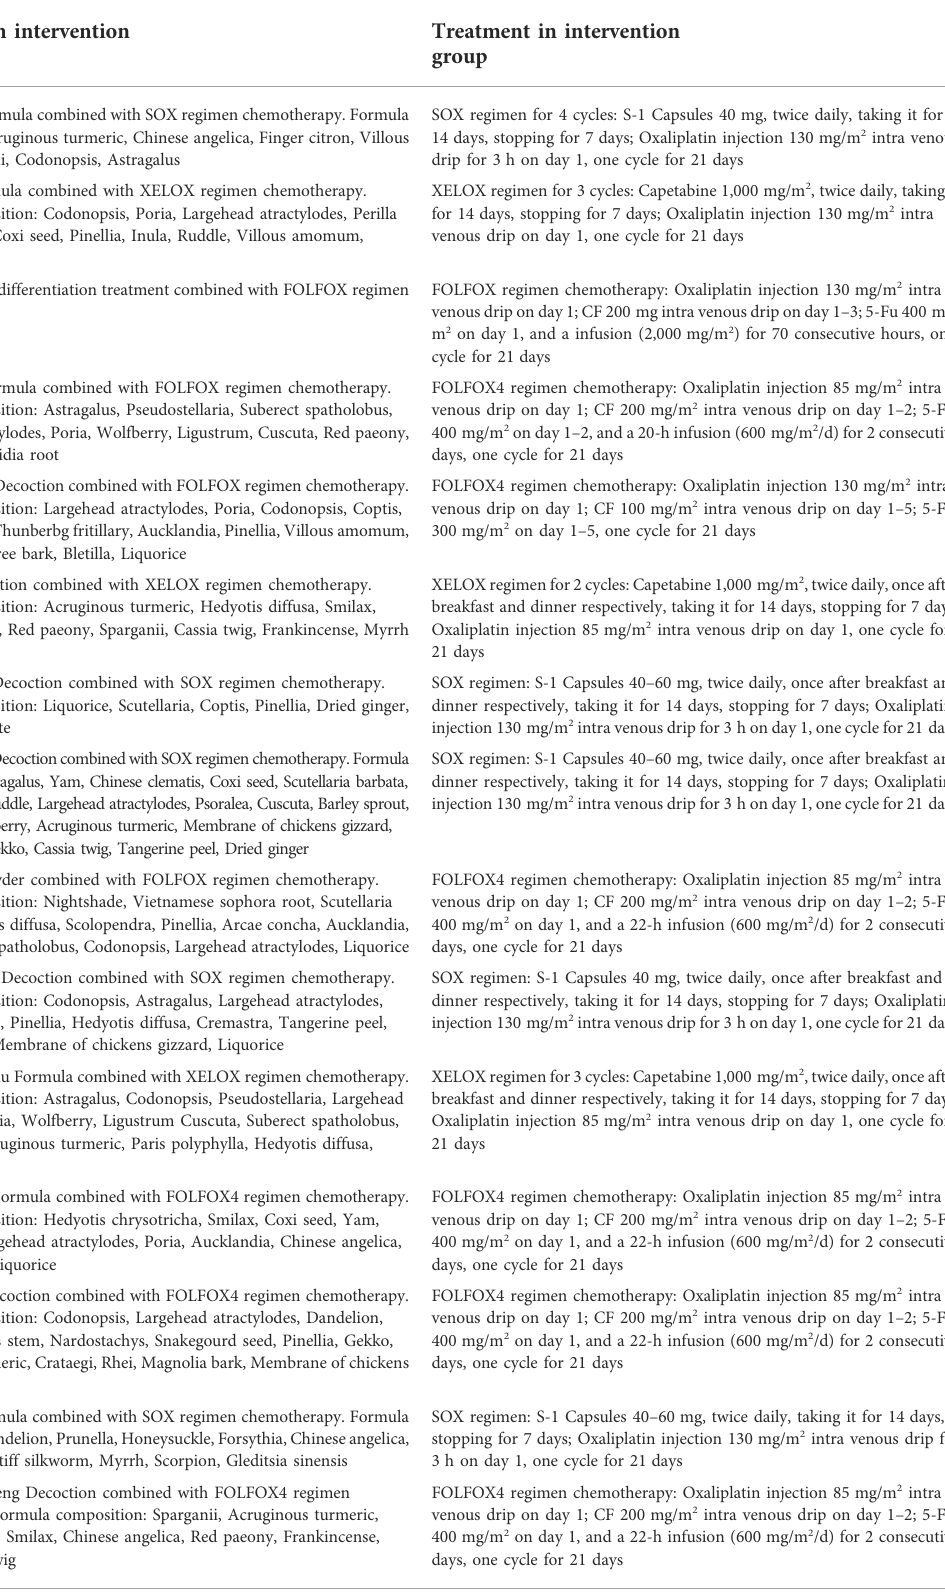
TABLE 2 Intervention details of included